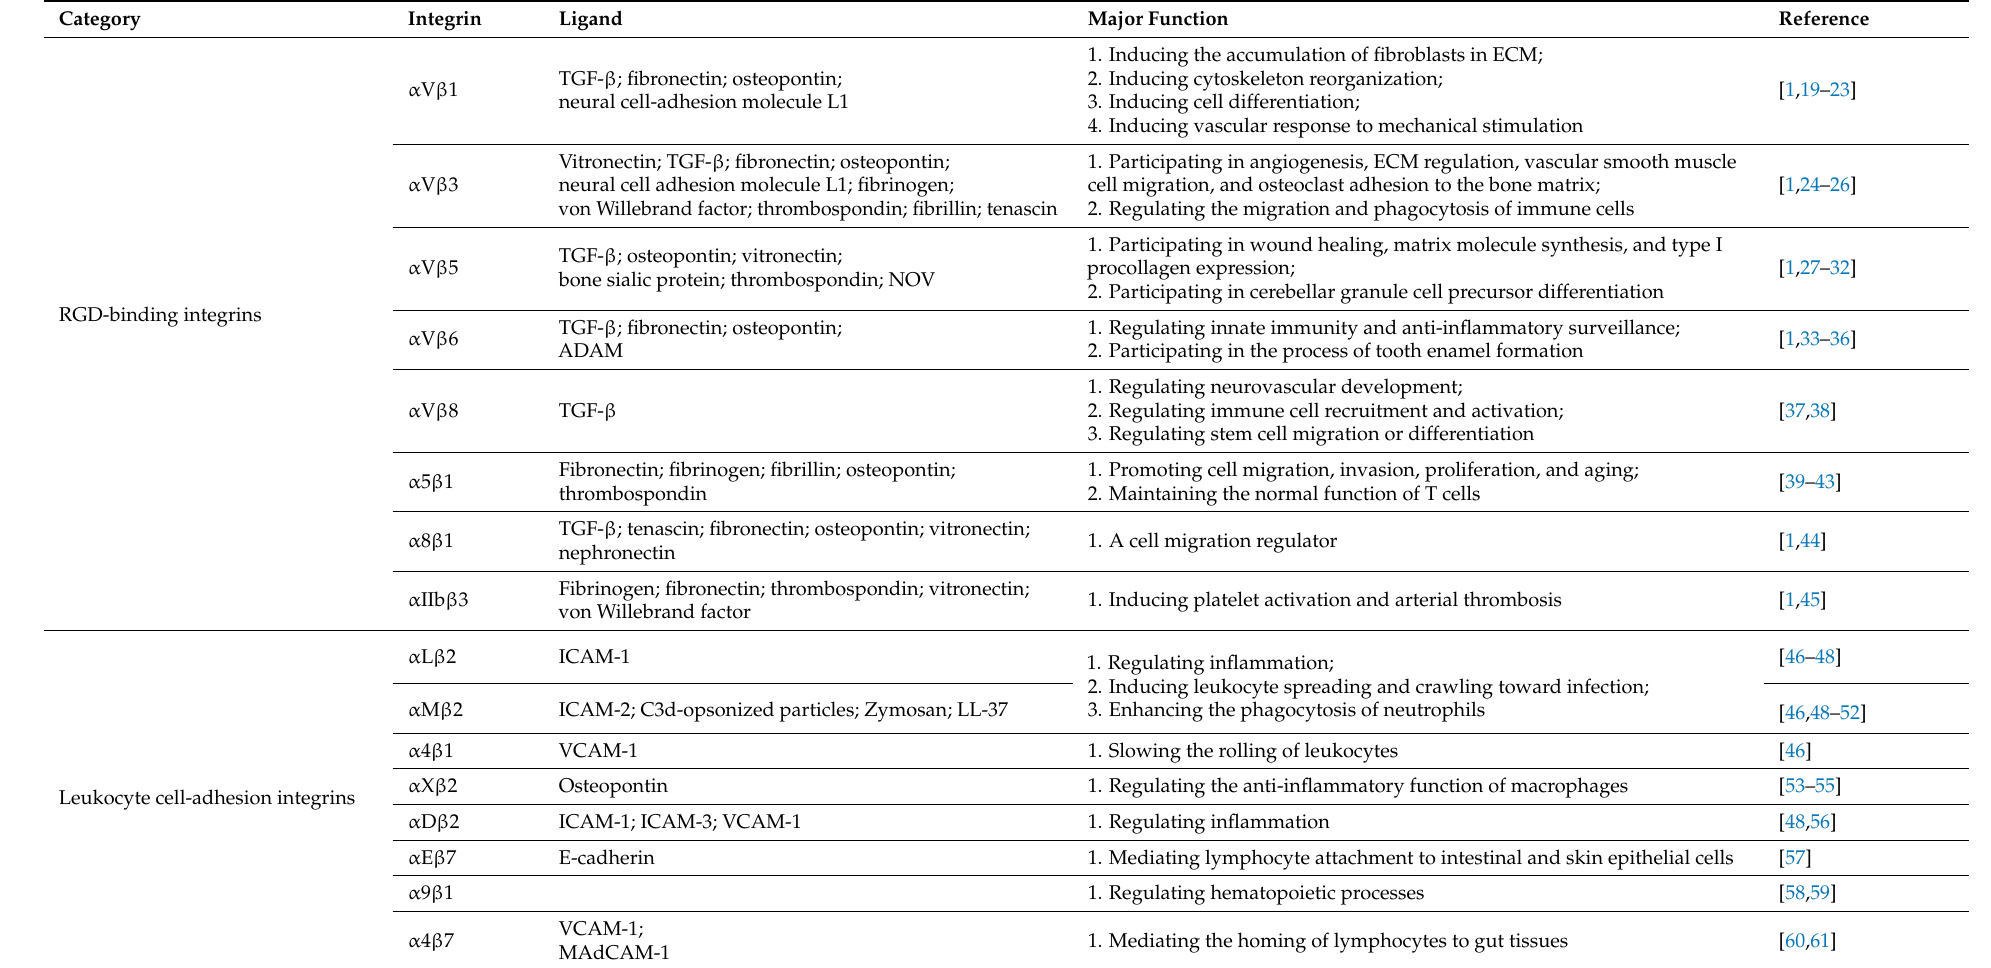
Table 1. Integrins, their ligands, and major